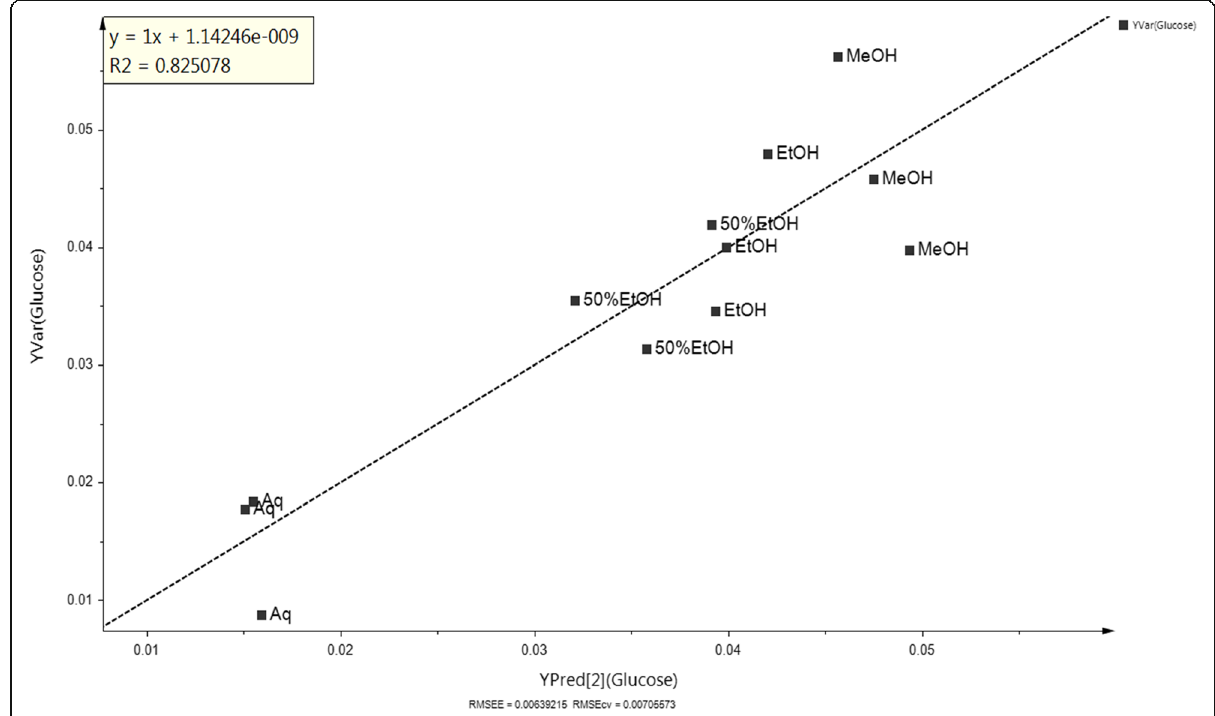
Fig. 9 Regression model on bioactivity of extracts towards chemical variable in diabetic and normal rat model treated with OSE in